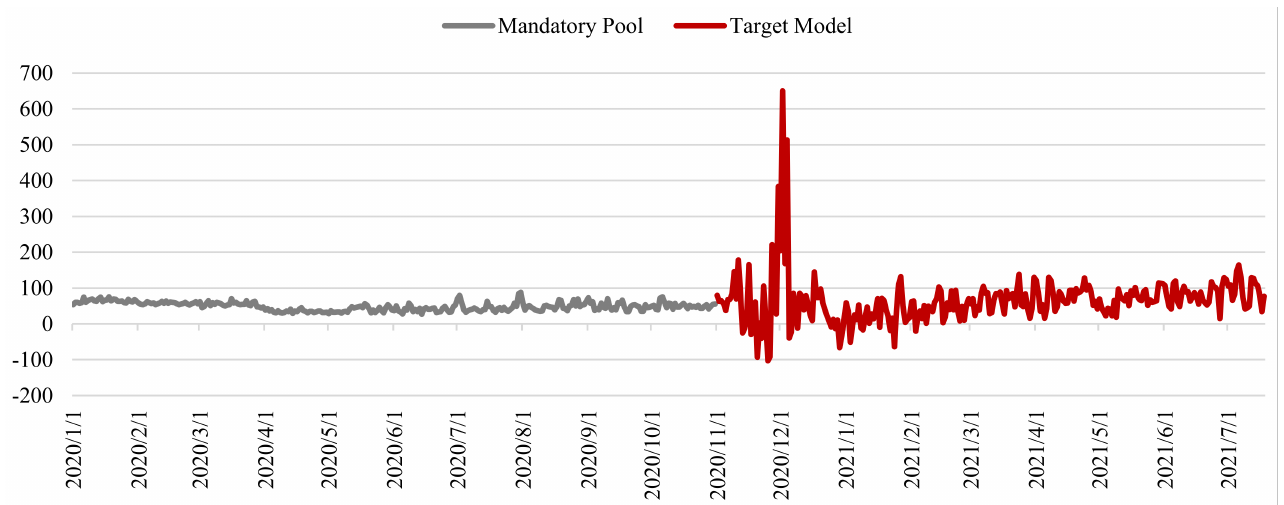
Figure 15. Daily Imbalance Price in Greece ( € /MWh), (January 2020–July 2021), Source: Hellenic Transmission System Operator and Authors’ estimations.